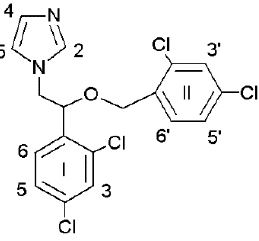
Figure 1. Chemical structure of miconazole.